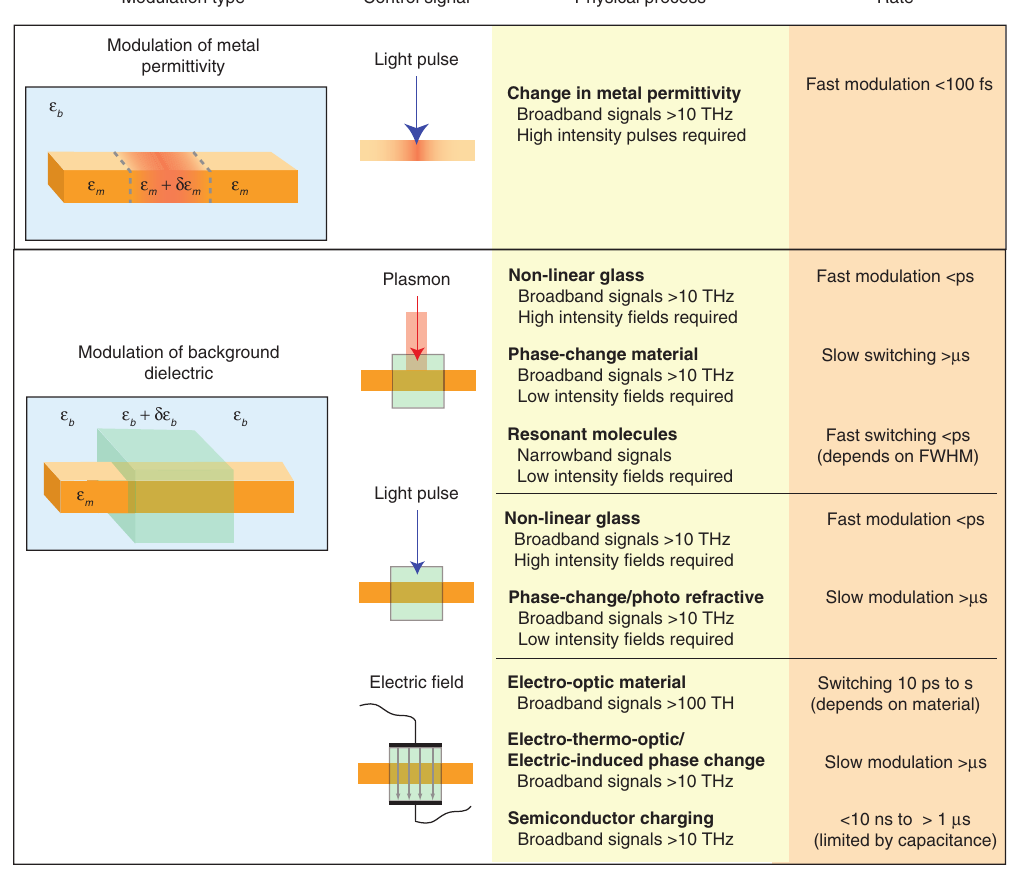
Figure 5: Comparison of plasmon modulation